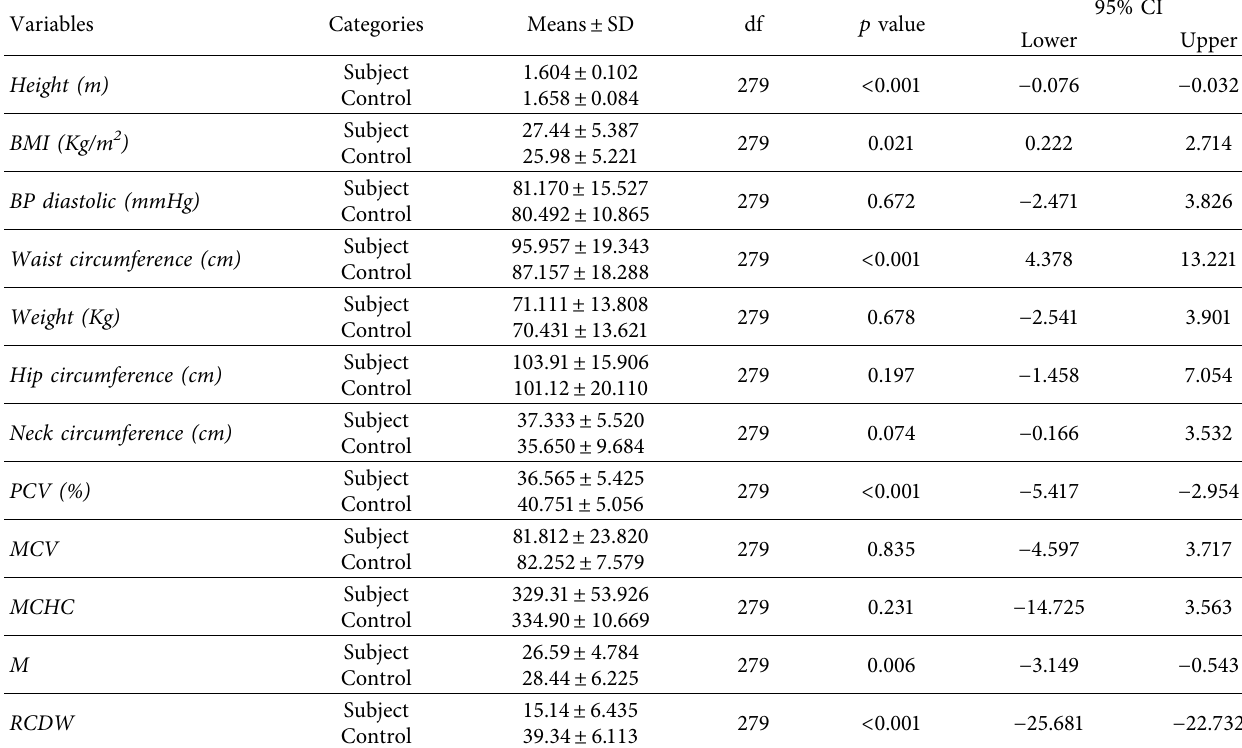
Table 4: Anthropometric measurement and red cell indices of diabetics and nondiabetics respondents.